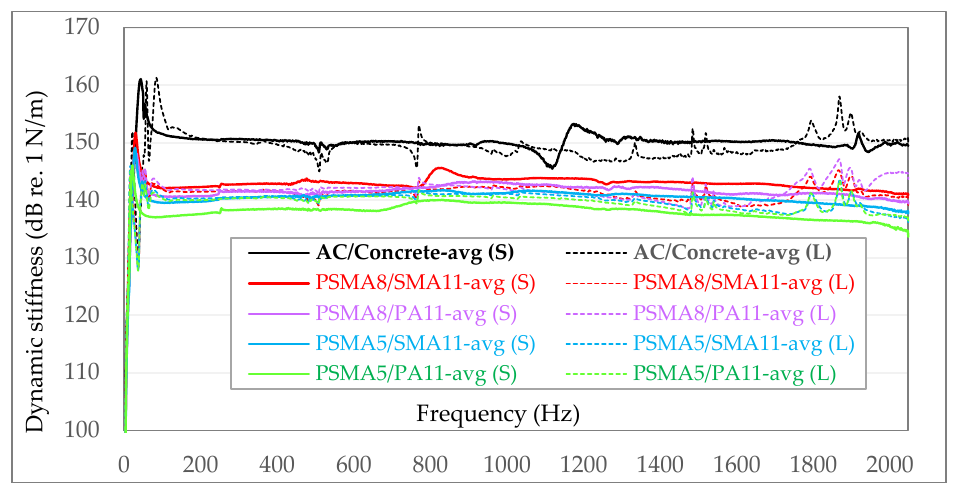
Figure 13. Comparison of the averaged values of dynamic stiffness from individual measurement series for in situ measurements on road surfaces (S) and on samples in the laboratory (L). The dynamic stiffness for selected frequencies (100 Hz, 300 Hz, 500 Hz and 1000 Hz) is also summarised in tabular form (Tables 2–11). Additionally, arithmetic averages and standard deviations were determined for each of the measurement series. Table 2. Dynamic stiffness (dB re. 1 N/m) for PSMA5 poroelastic pavement with PA11 as binder course—measurements in situ (S). Sample